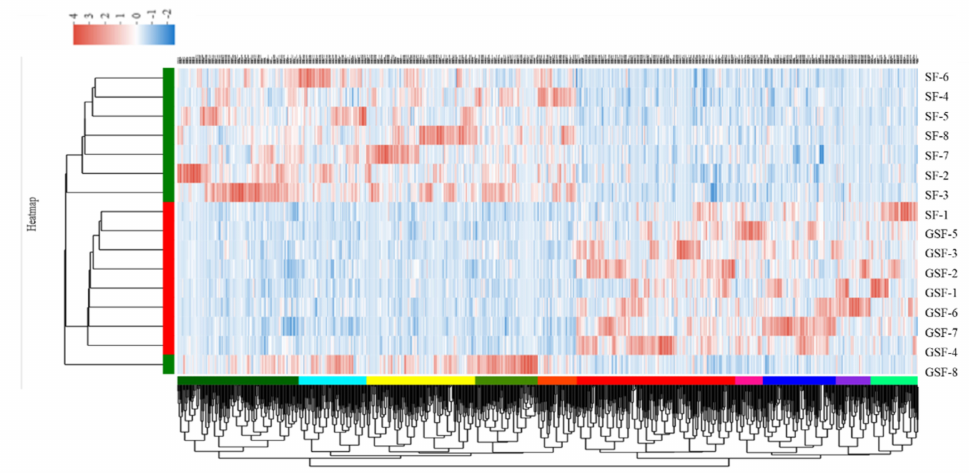
Figure 6. Cluster heat map in LD muscle of Tan lamb between the SF and GSF groups. GSF, graze- feeding group; SF, stall-feeding group. n = 8 for each